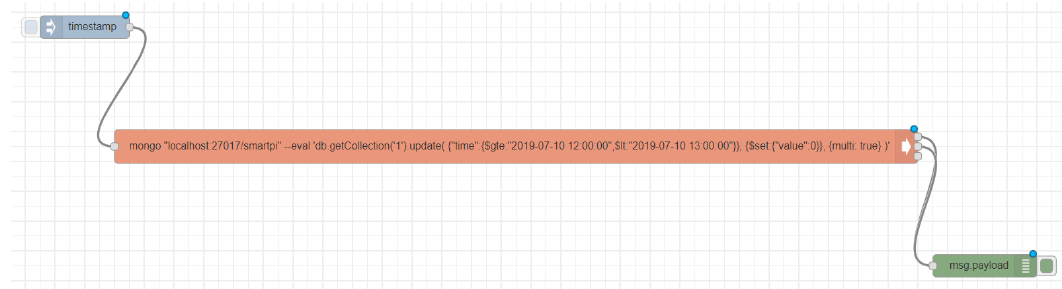
Figure 9. Flow introduced by the malware to allow a modification in the database or other actions with malicious